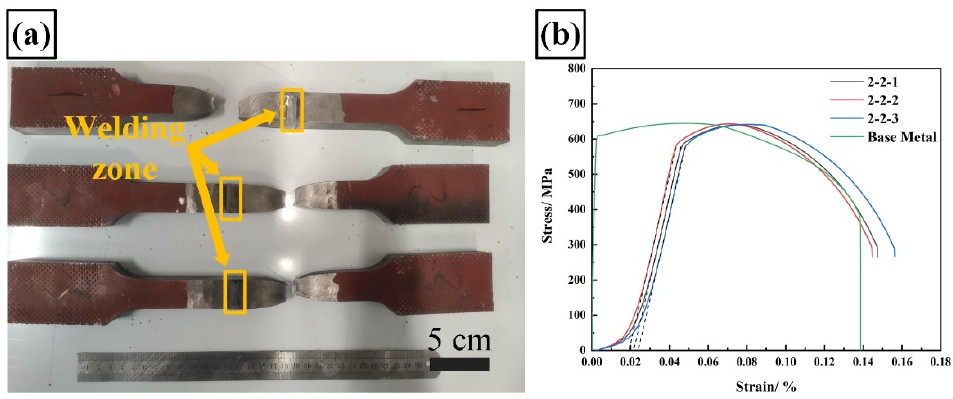
Figure 9. ( a ) Tensile specimen after fracture; ( b ) Stress-strain curves.